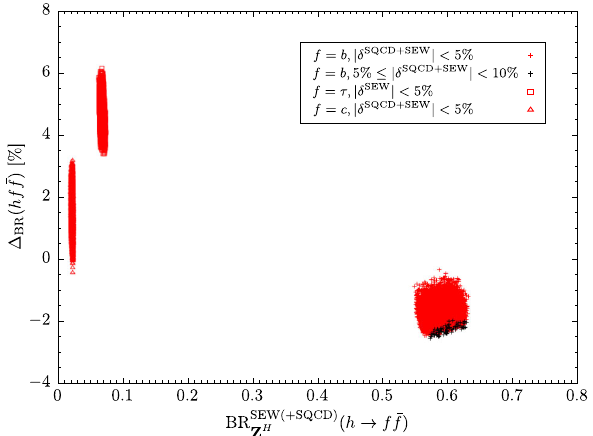
Fig. 3 Scan2: Same as Fig. 2 but for the SM-like Higgs boson h that is h u